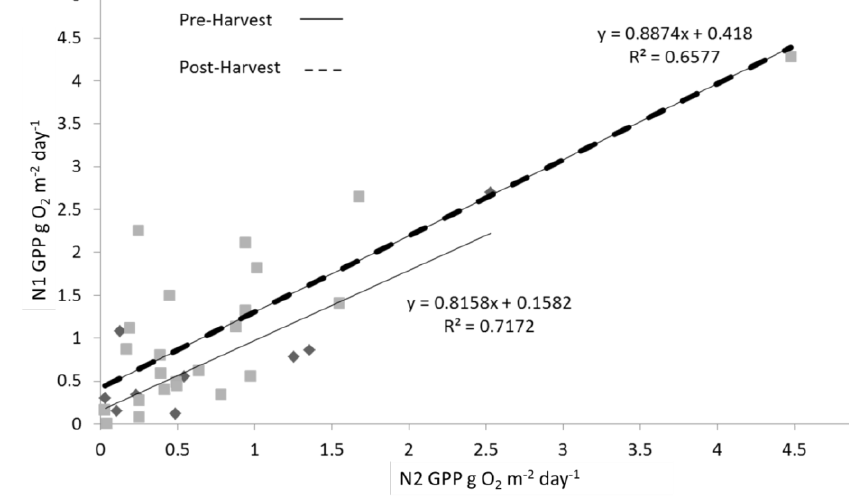
Figure 8. Monthly means of GPP rates (g O m −2 day −1 ) from N1 regressed against 2 monthly means of GPP rates from N2 for both pre-harvest (solid line; diamonds) and post-harvest (dashed line; squares) periods. Differences between the two regression lines, both in slope and in y-intercept, were tested using analyses of covariance; slope ρ = 0.798, y-intercept ρ =